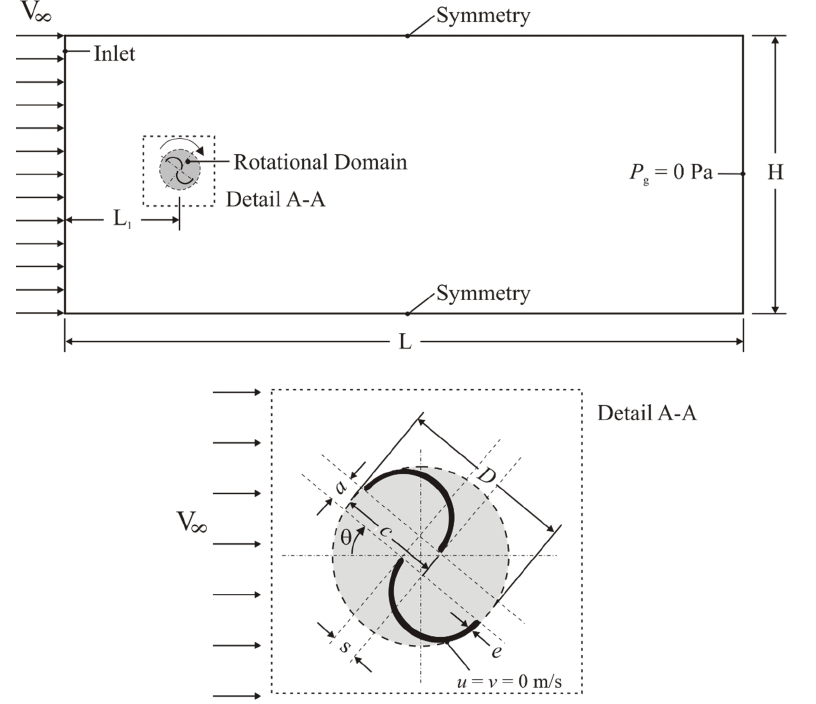
Figure 1. Schematic representation of the computational domain of turbulent air flow over a free Savonius turbine used for verification/validation of the present numerical model ( Case 1 ).